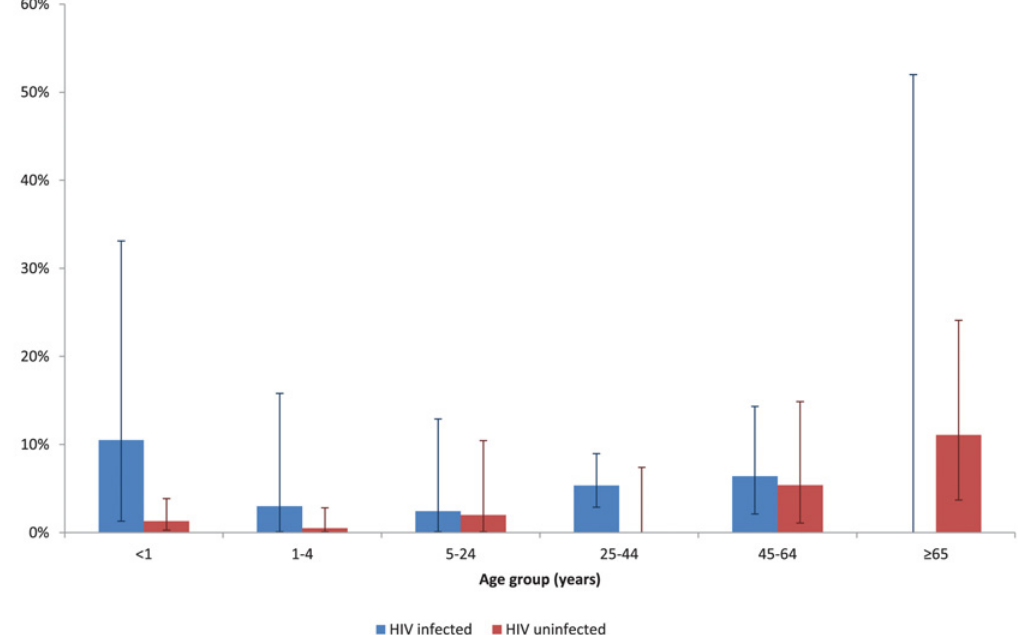
Fig 3. Case-fatality proportions by age group and HIV status amongst patients hospitalized with influenza-associated SARI at four sentinel surveillance sites in South Africa, 2009 – 2013 (n = 1039).